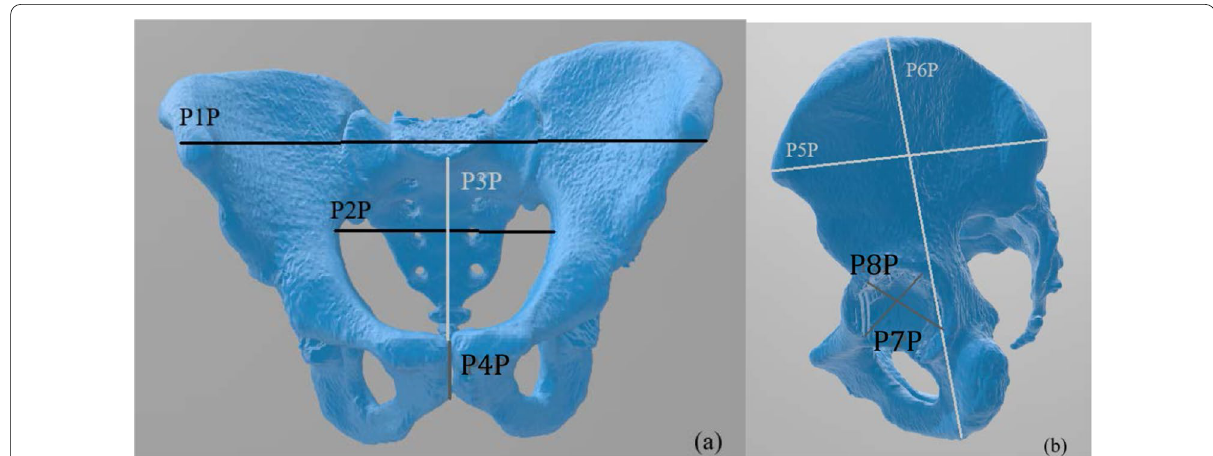
Fig. 3 Inter-landmark distances shown on the pelvic at anterior view ( a ) and lateral view ( b ). Screenshots obtained from Microsoft 3D Builder software